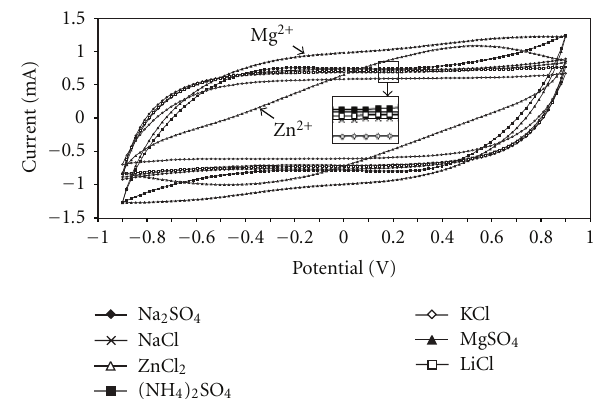
Figure 9: E ff ect of electrolyte composition on the shape of cyclic voltammograms at a scan rate of 50 mV/s. Inset shows a magnified portion of various CV